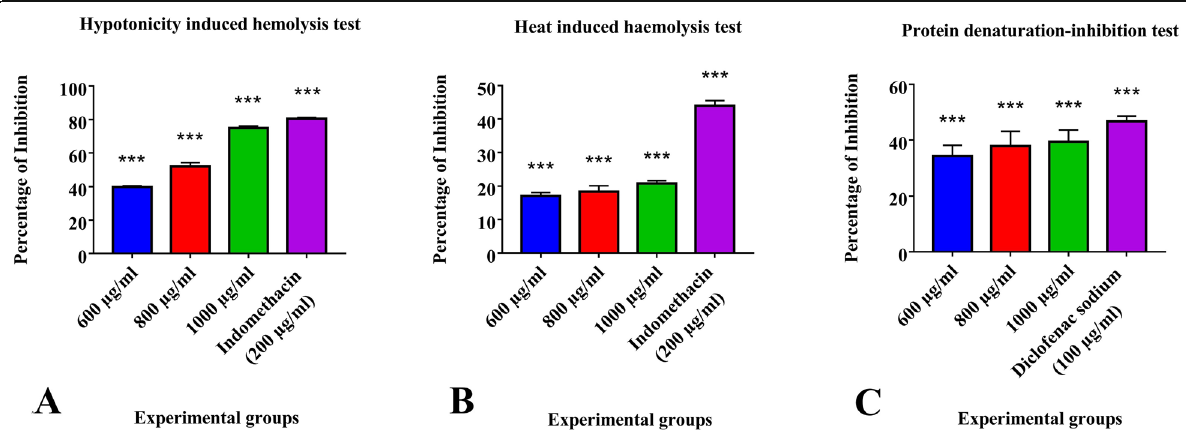
Fig. 1 Results of in vitro anti-inflammatory tests in graph. Hypotonicity-induced hemolysis test of hRBC ( a ), heat-induced hemolysis test of hRBC ( b ), and protein denaturation-inhibition test of hen ’ s albumin ( c ) when treated with Aloe vera gel homogenate. All data represents % of inhibition ± SEM. Significance value at P < 0.001 is indicated as ***. Indomethacin and diclofenac sodium are used as standard drugs in experiments as indicated. Control group (not shown in the figures) is considered to exert 100%